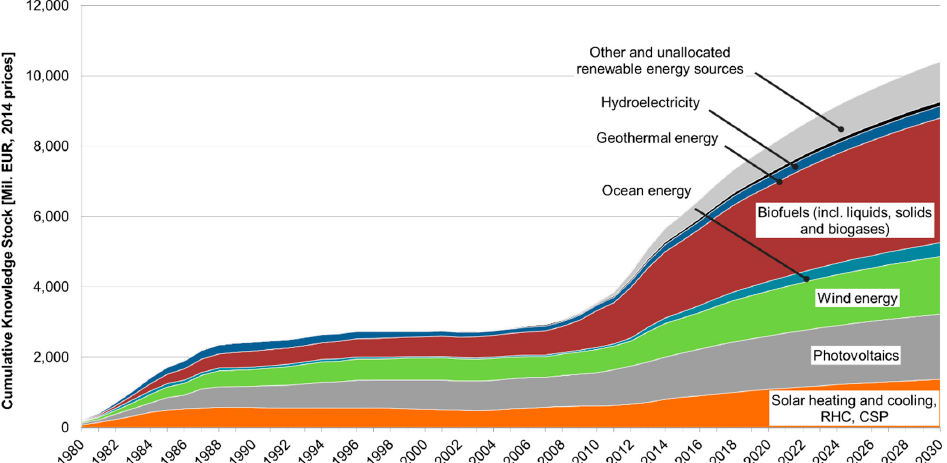
Figure 5. Cumulative RES knowledge stock by public R&D expenditures of the EU MS (Mil. EUR, BAU scenario) (2014 prices and exc. rates; knowledge depreciation, 10%; time lag, three